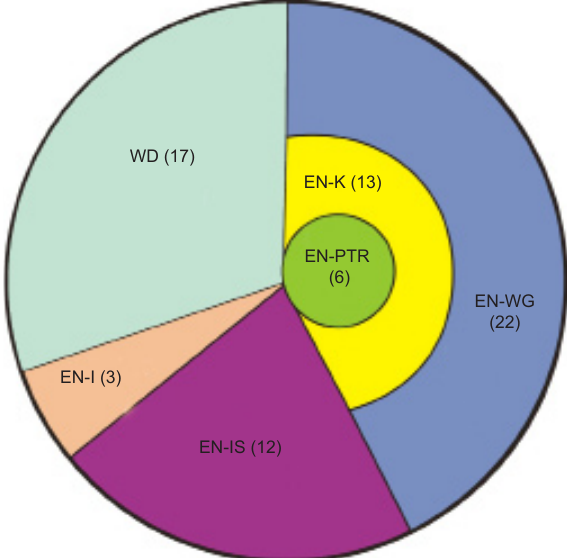
Figure 3. Endemism of fishes collected from Periyar Tiger Reserve. WD - Widely Distributed; EN–IS - Endemic to Indian Subcontinent; EN- I - Endemic to India; EN-WG - Endemic to Western Ghats; EN-K - Endemic to Kerala; EN-PTR - Endemic to Periyar Tiger Reserve